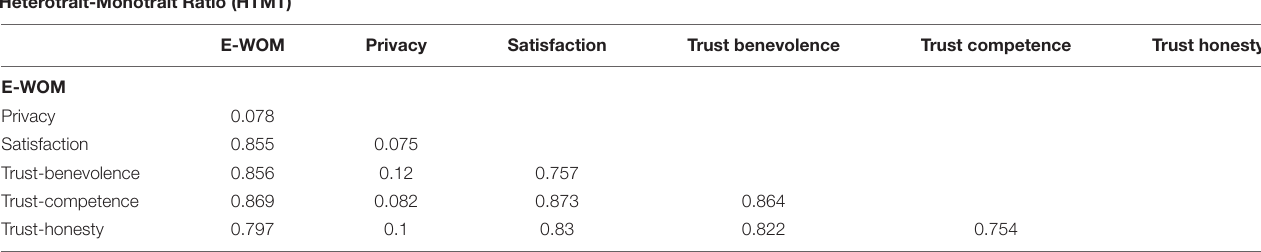
TABLE 3 | Measurement of the fist-order model (discriminant validity). Heterotrait-Monotrait Ratio (HTMT) E-WOM Privacy Trust benevolence Trust competence